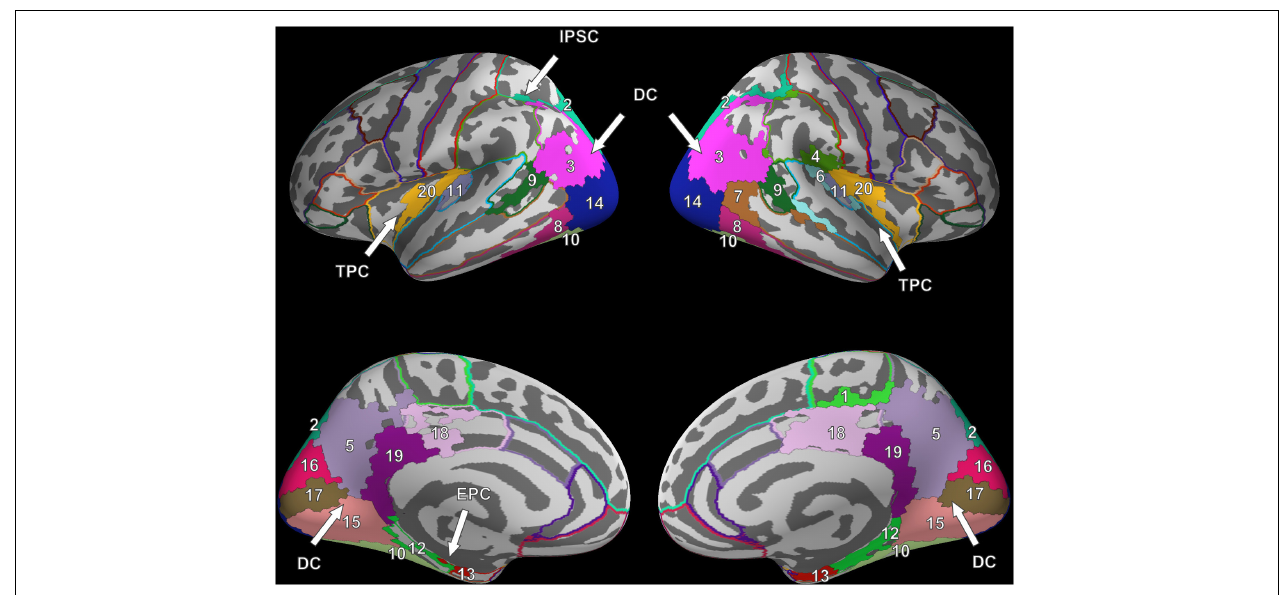
FIGURE 2 | Cluster results for the fixation onset contrast of image presentation during FV vs. fixation cross presentation. Separate ROIs according to the Desikan-Killiany atlas are highlighted in different colors (Desikan et al., 2006). The identified clusters (DC, dorsal cluster; TPC, temporoparietal cluster) are mostly symmetric across hemispheres. Corresponding ROI names are listed in Table 1 .